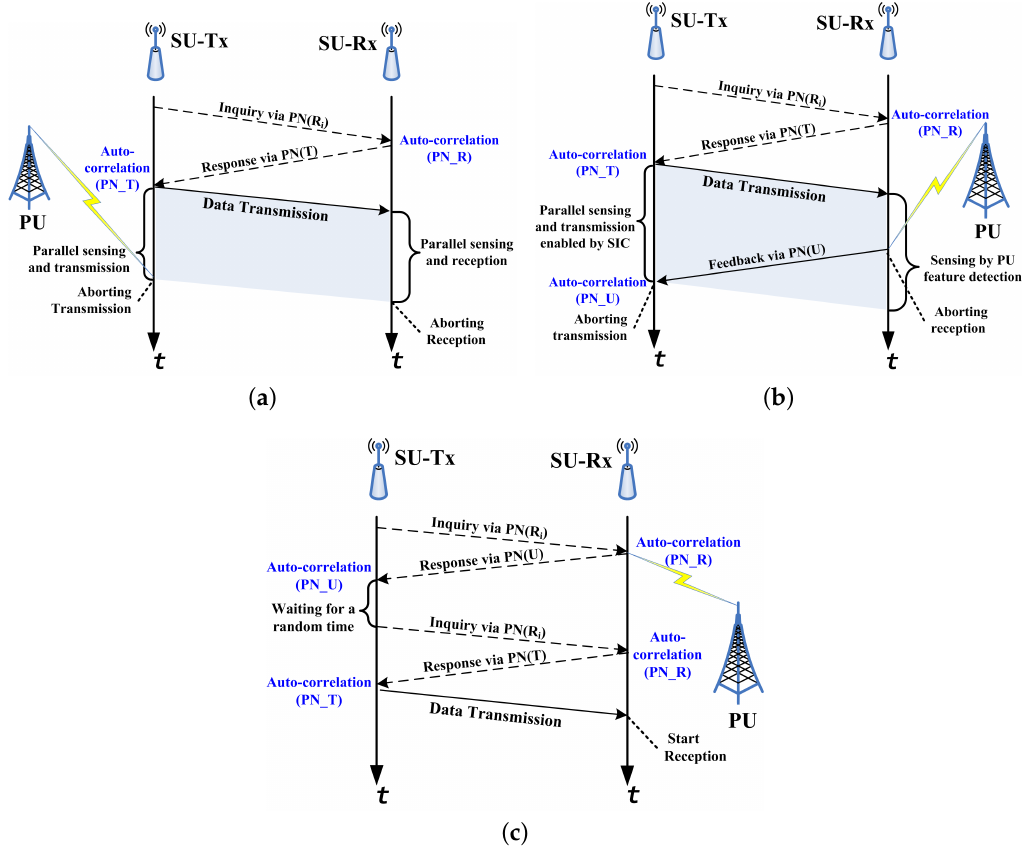
Figure 3. Flowcharts of the PaCoSIF. Three typical scenarios are represented: ( a ) PU’s return is detected by the SU-Tx; ( b ) PU’s return is detected by the SU-Tx; ( c ) multiple handshakes due to spectrum